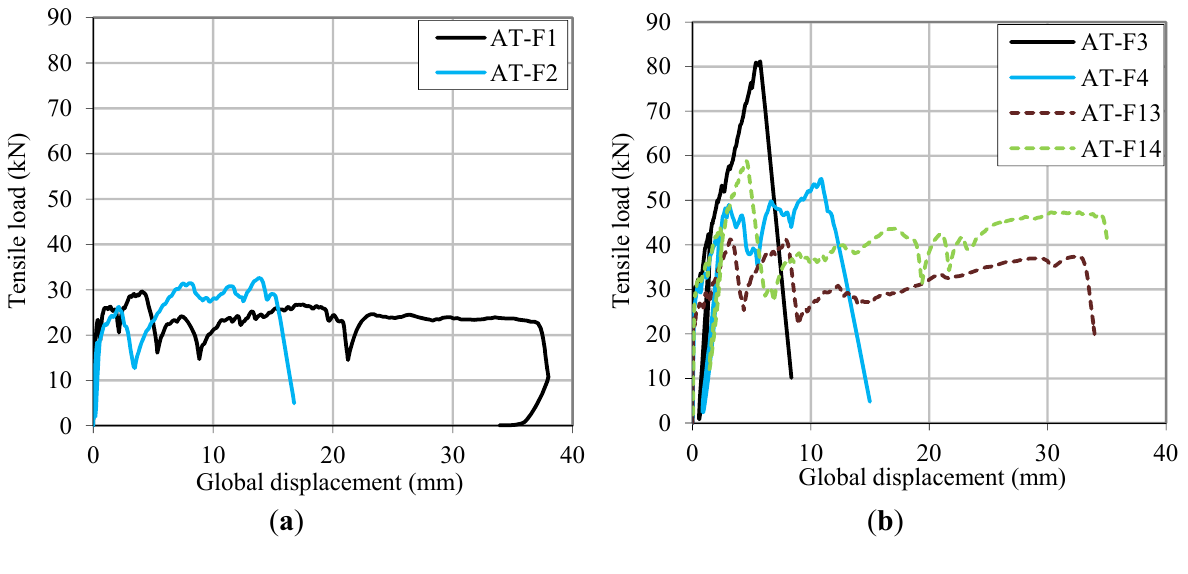
Figure 14. Load-displacement curves. ( a ) Specimens AT-F1/F2 with mesh L200; and ( b ) Specimens AT-F3/F4/F13/F14 with mesh